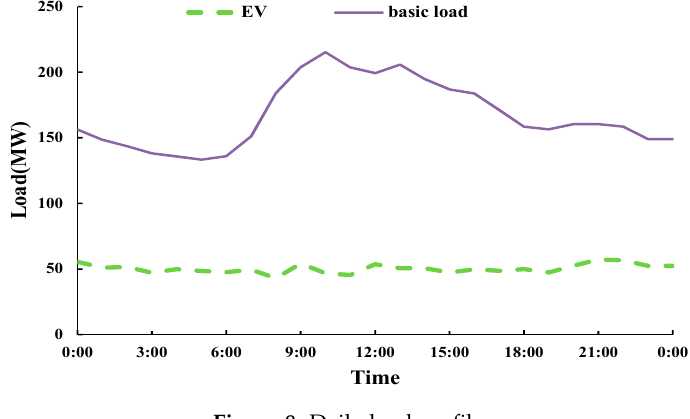
Figure 8. Daily load profile.